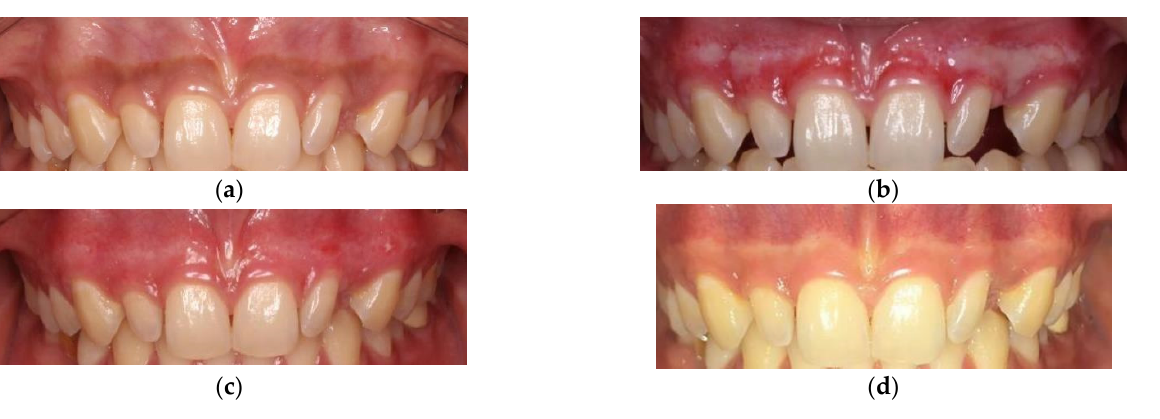
Figure 2. DOPI score using CO 2 laser at weeks 1, 4 and 12 after treatment.